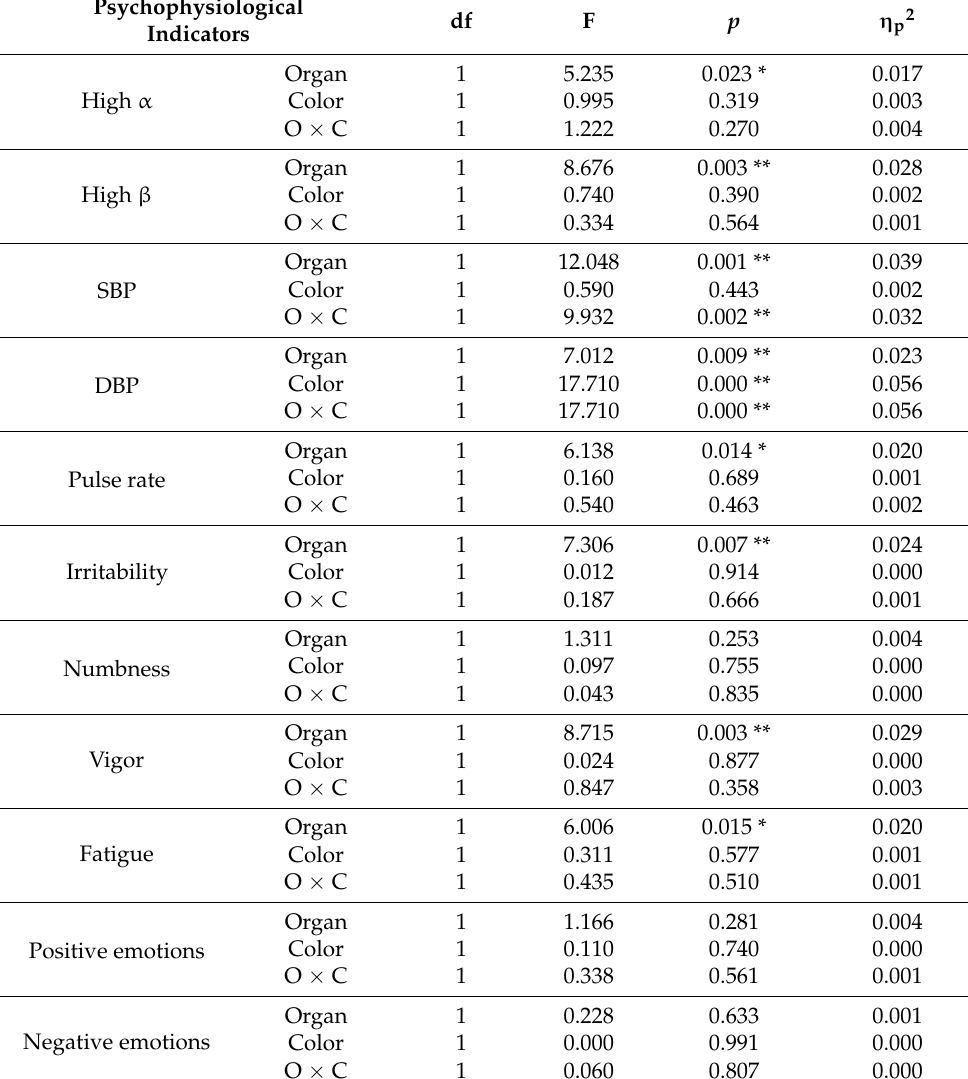
Table 2. Main effect and interaction effect of colors and organs on the psychophysiological